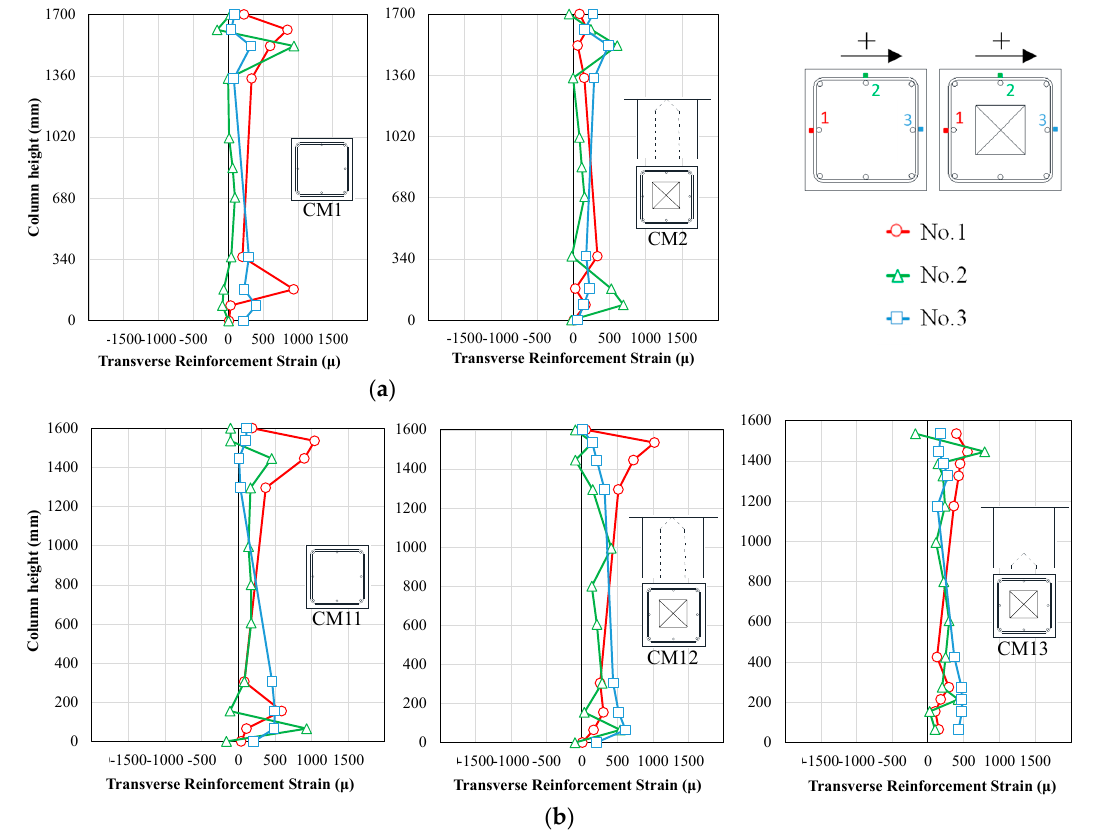
Figure 9. Strain distributions of transverse reinforcement ( R = 1.0%): ( a ) N-series; ( b ) S-series.